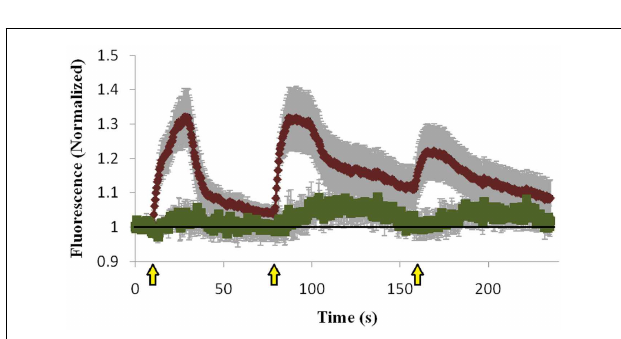
FIGURE 5 | Quantification of co-translocation of Doc2B Mid –mRFP and Munc13-1 wt –EGFP . Quantification graph of theTIRF experiment demonstrating translocation of Doc2B Mid and low translocation of Munc13-1 wt during the first KCl application ( n = 8). Munc13-1 wt translocation becomes more pronounced at the second and third KCl application but still lower compared to co-expression with Doc2B wt . Black line marks the value of 1 (no translocation).Yellow arrows indicate KCl application.